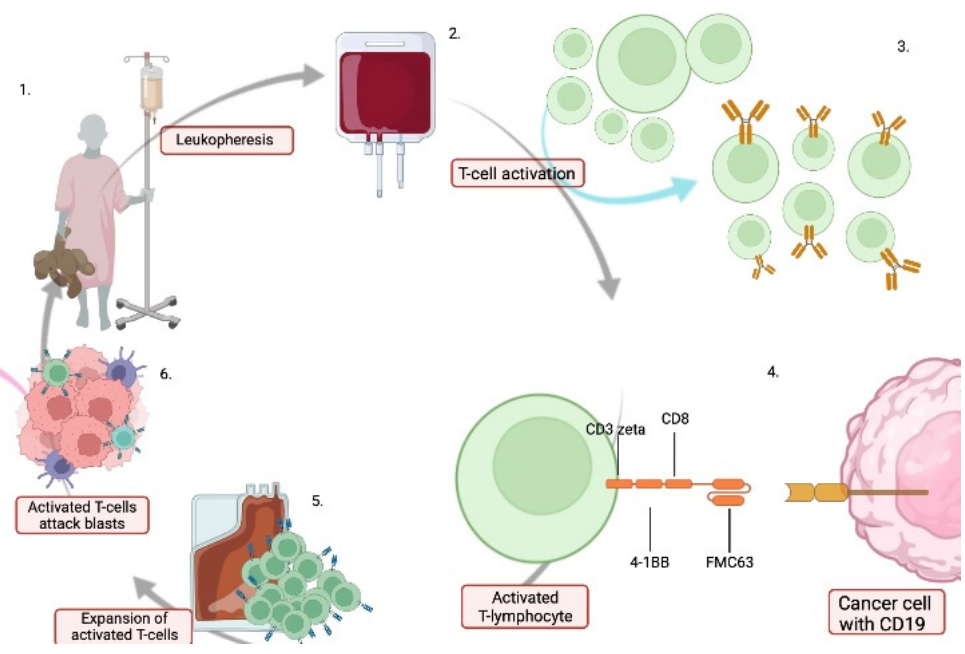
Figure 2. Steps of the CART-cell therapy. 1—Peripheral blood mononuclear cells are collected from the patient by plasmapheresis. 2—The leukapheresis material is cryopreserved and transported to the laboratory. 3—T-cells are activated with beads that are coated with anti-CD3/CD28 antibodies. They are then transduced with a self-activating vector containing an anti-CD19 CAR transgene. 4—There is a CD19 antigen on the tumor cell. Opposite the tumor cell is the CAR tisagenlecleucel. It consists of a single-chain CD19-specific mouse antibody fragment (FMC63), a CD8-a hinge, and a transmembrane region linked to domains: CD3-zeta (signaling) and 4-1BB (costimulatory) domain. The 4-1BB domain serves as a costimulatory signal for cell activation. 5—Cell multiplication is carried out until sufficient numbers are reached. 6—The finished product, which has the ability to attack blastic cells, is administered to the patient. Image created with biorender.com (accessed on 14 March 2022).